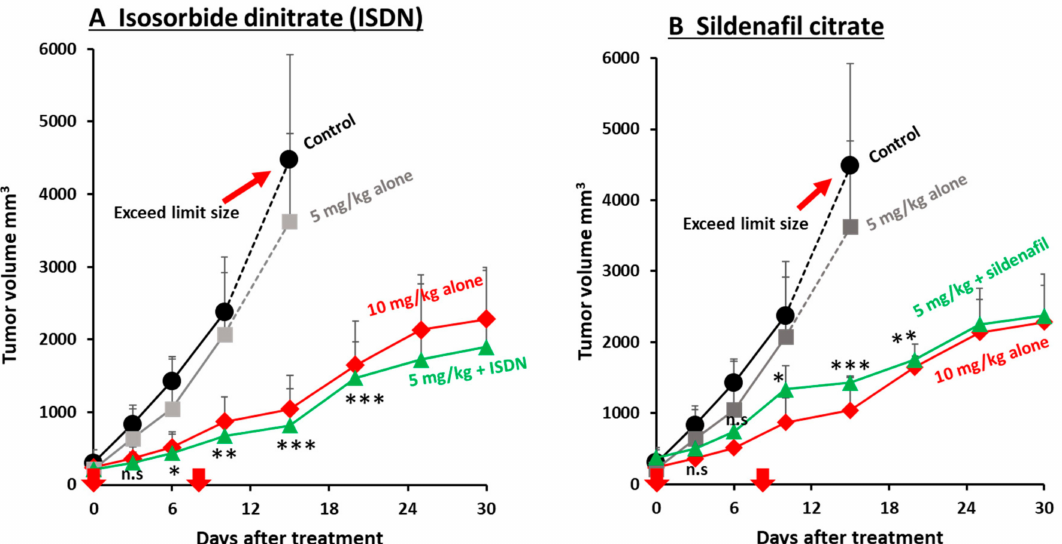
Figure 5. Improvement in the antitumor effect of SGB-complex by using EPR-effect enhancers in the C26 tumor model. ( A ) Antitumor effect of the SGB-complex given with ISDN. ( B ) Antitumor efficacy of the SGB-complex given with sildenafil. ISDN increased the antitumor effect of the SGB-complex about 3-fold; sildenafil, 1.5- to 2-fold. Arrows indicate times of drug administration. Data are expressed as means ± SD. * p < 0.05, ** p <0.01, *** p < 0.001, combination group vs. SGB 5 mg/kg group. See text for